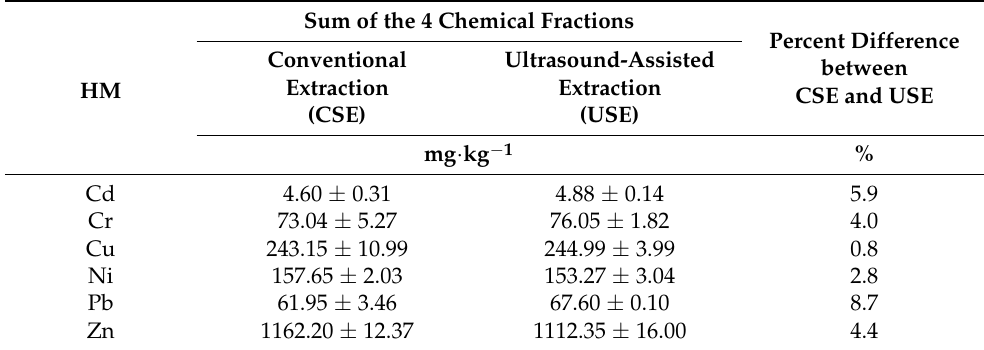
Table 8. The percentage differences between the content of heavy metals in the two methods of sequential extraction in dewatered sewage